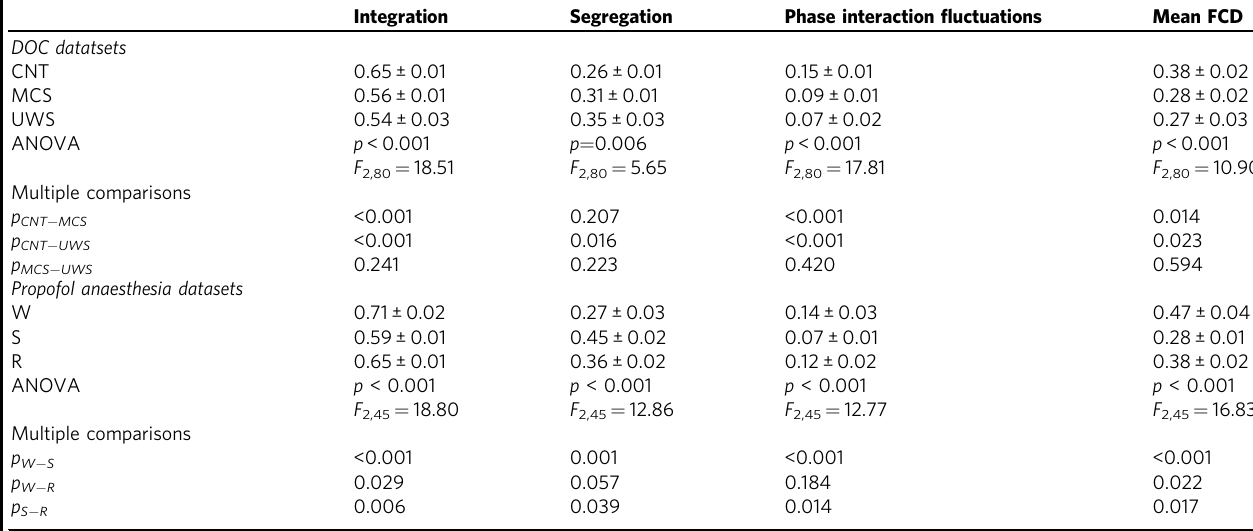
Thetableshowsthemeanvaluesandstandarderroroftheempiricalmeasuresofintegration,segregation,phaseinteraction fl uctuationsandmeanFCD.Groupcomparisonstatisticswerecomputedwith a one-way ANOVA, followed by FDR correction (adjusted p -values are